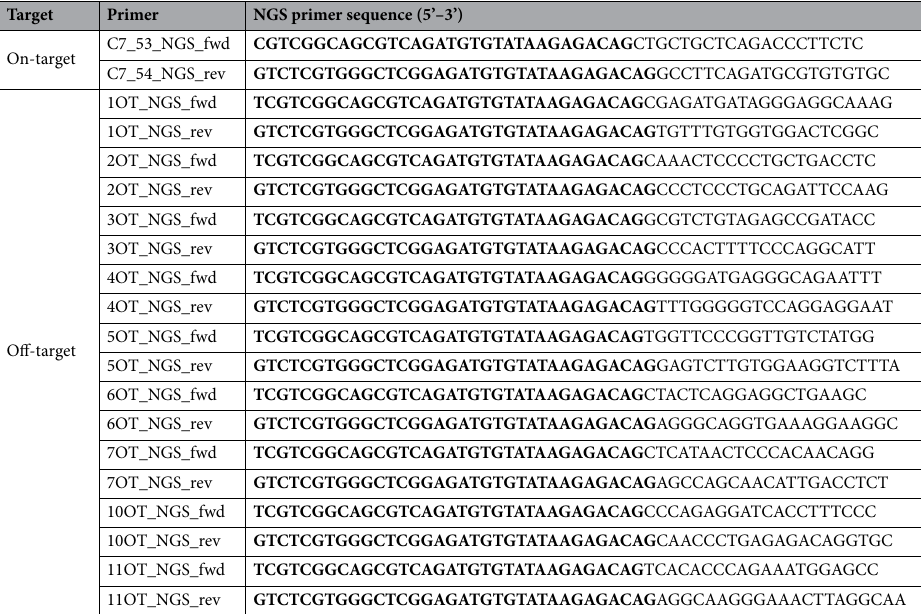
Table 1. Primers used for NGS